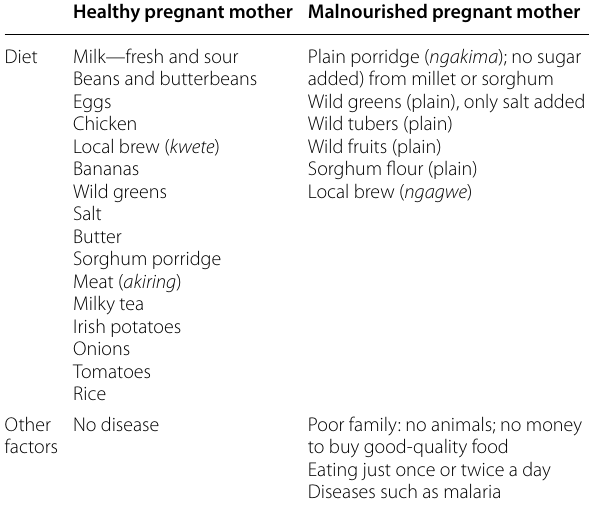
Table 3 Diets and other factors associated with healthy vs.